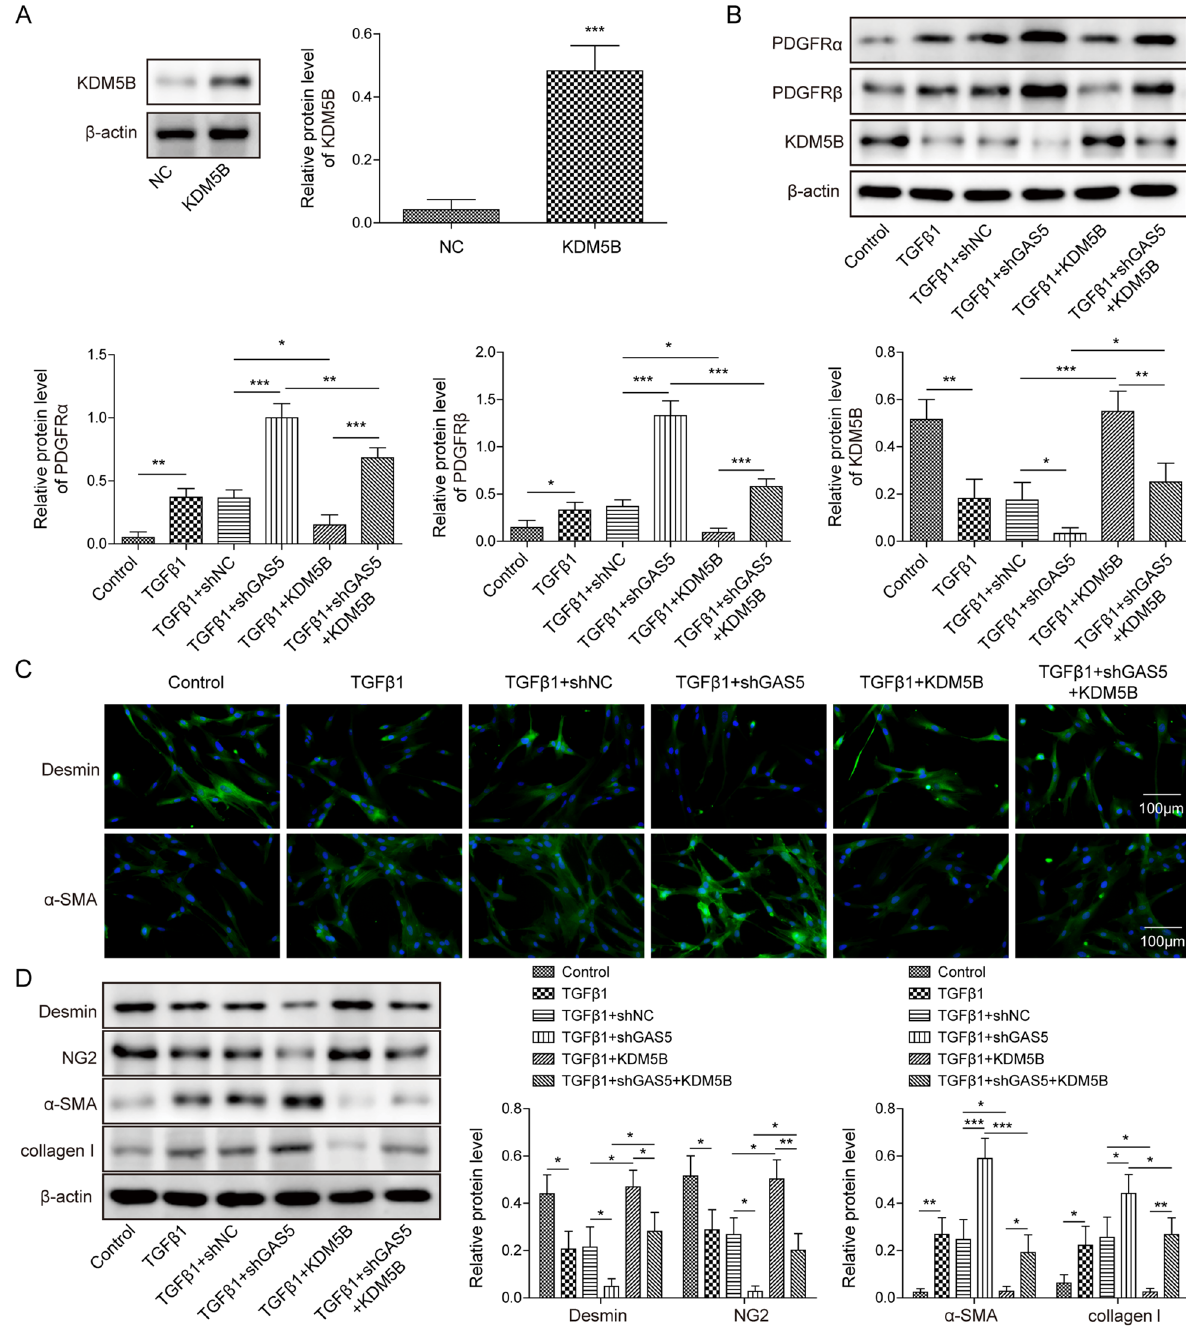
Fig. 7 GAS5 repressed TGF-β1-induced pericyte–myofibroblast transformation by regulating the KDM5B/PDGFR α/β signaling pathway. Pericytes were transfected with pcDNA3.0 containing KDM5B (KDM5B) and/or shGAS5 and then exposed to TGF-β1 (10 ng/mL) for 12 h. They were divided into the following groups: control, TGF-β1, TGF-β1 analysis of the expressions of KDM5B and PDGFR α/β after KDM5B overexpression. C Immunofluorescence staining to evaluate the expressions of desmin and α-SMA. D The protein levels of desmin, NG-2, α-SMA, and collagen I were assessed via Western blotting. For A–D, n ** P < 0.01, *** P <